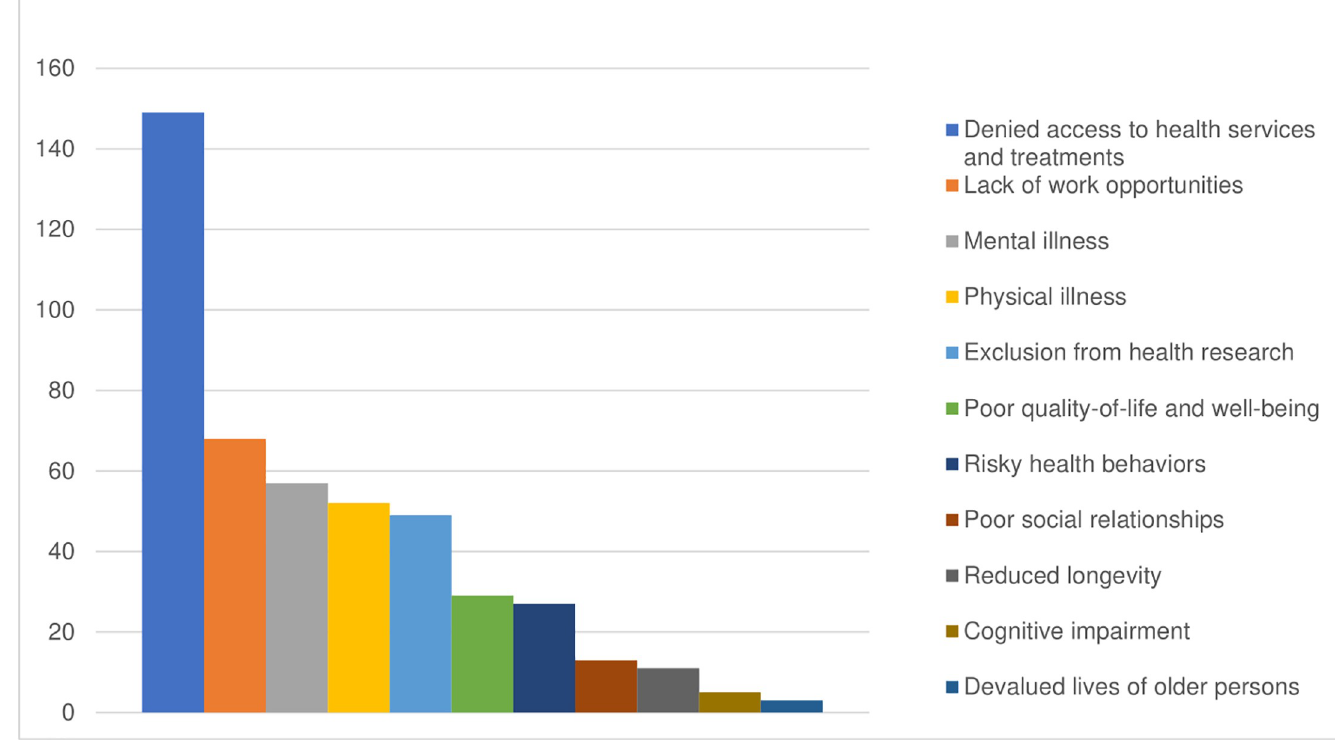
Fig 2. Impact of ageism on health in 11 health domains: Distribution of